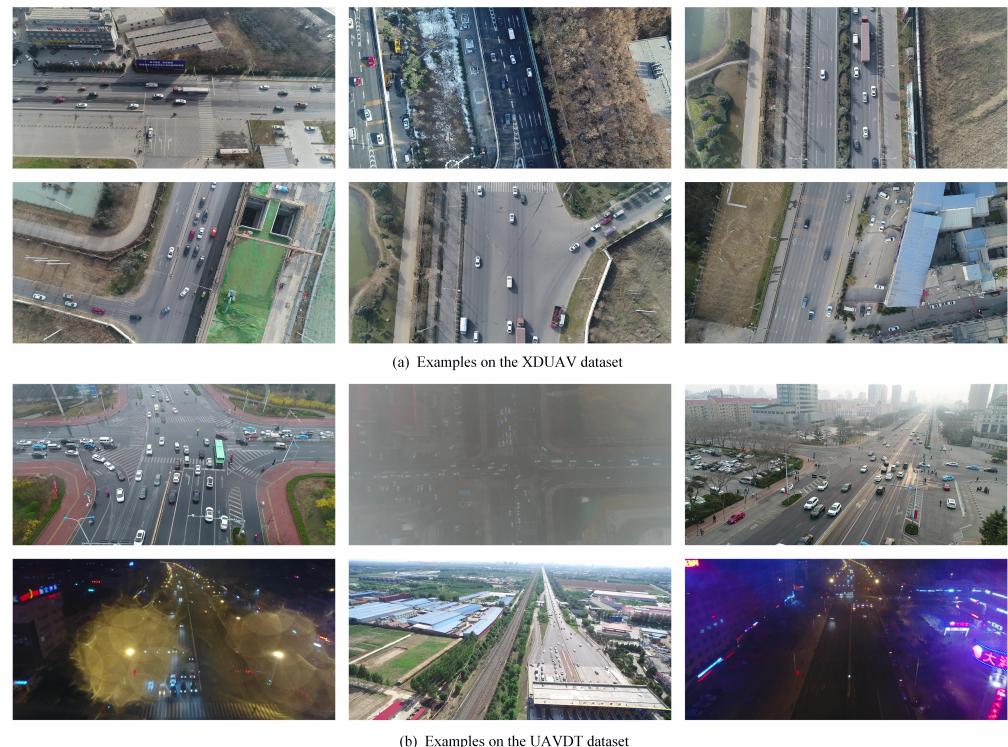
Figure 3. Samples in various scenes from different vehicle datasets. ( a ) examples on the XDUAV dataset; ( b ) examples on the UAVDT dataset. Table 1. The number of each category vehicle in the XDUAV dataset and the UAVDT dataset.